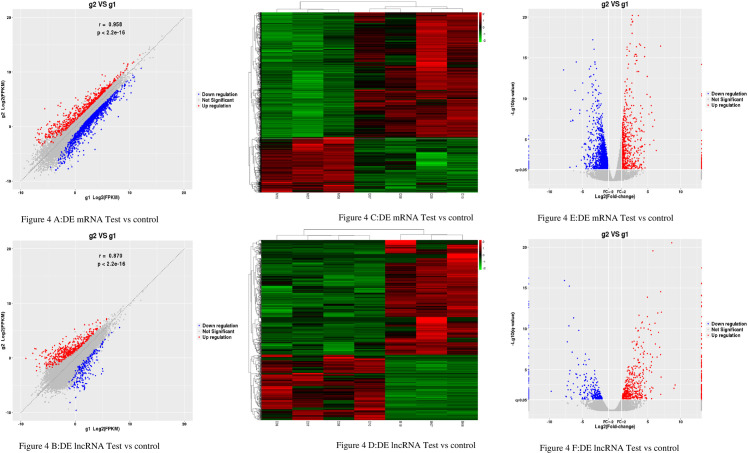
The Expression Profiling Changes of lncRNAs and mRNAs in Rats thoracic aorta Tissue: (4A and 4B) Volcano plot showing up-and down-regulated mRNAs (A) and lncRNAs (B) of rats thoracic aorta tissue in the test group compared with the control group; Red represents up-regulation, blue represents down-regulation, and gray represents no significant difference in gene expression. (4C and 4D) Heatmap of mRNAs (4C) and lncRNAs (4D) displaying hierarchical clustering of changed lncRNAs and mRNAs of rats thoracic aorta tissue in the test group compared with the control group; up- and downregulated genes are colored in red and blue, respectively. (4E and 4F) scatter plot showing up-and down-regulated mRNAs (E) and lncRNAs (F) of rats thoracic aorta tissue in the test group compared with the control group; Red represents up-regulation, blue represents down-regulation, and gray represents no significant difference in gene expression. g1 represents the control group while g2 represents the test group in all the figures.